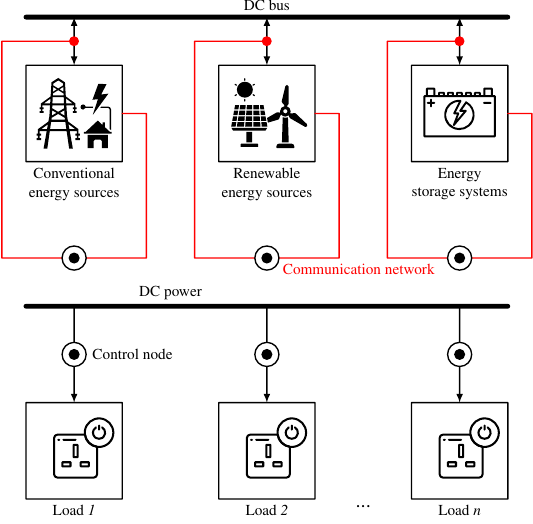
Figure 4. Decentralised nanogrid